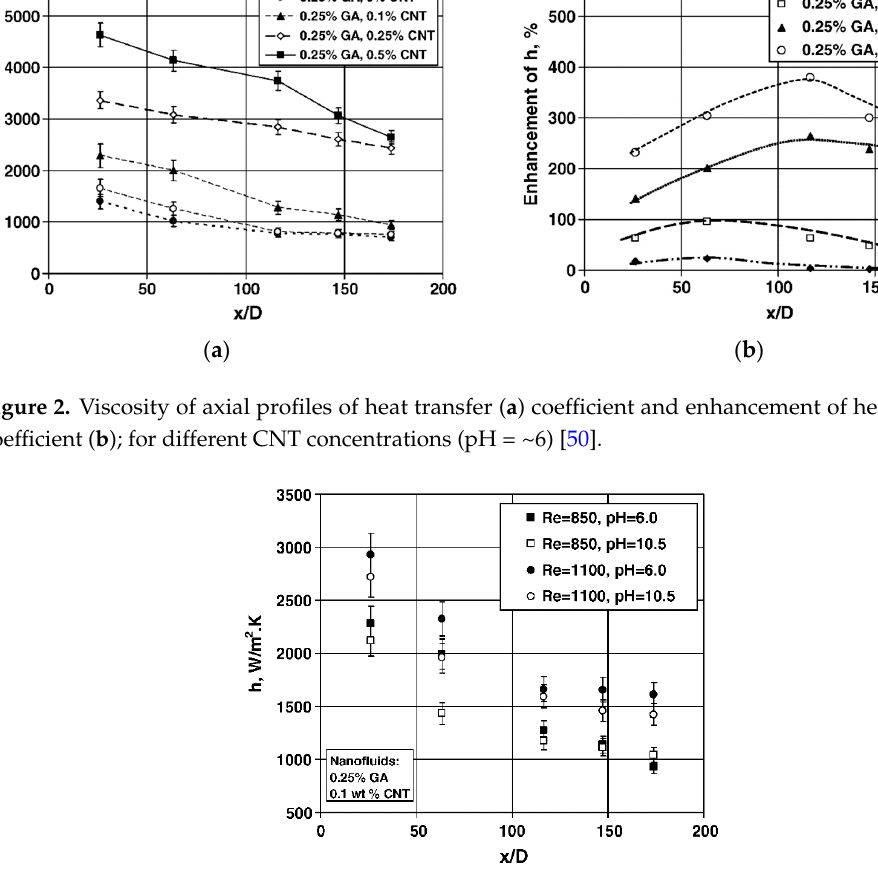
Figure 3. Effect of pH on the convective heat transfer [50].